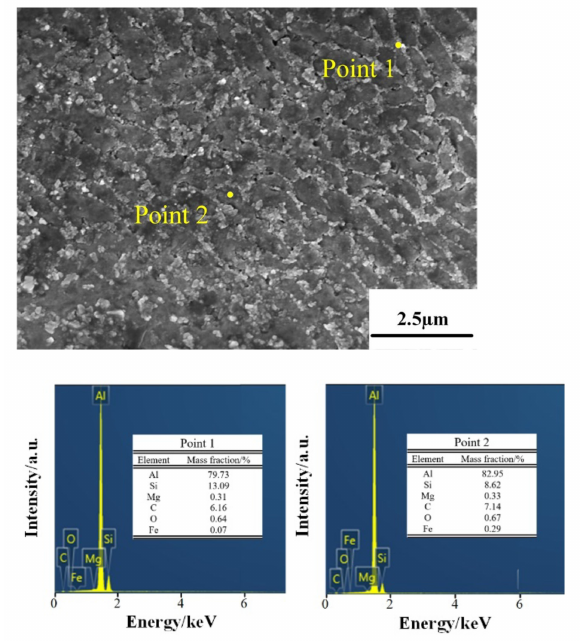
Figure 7. EDS results for the deposited samples.